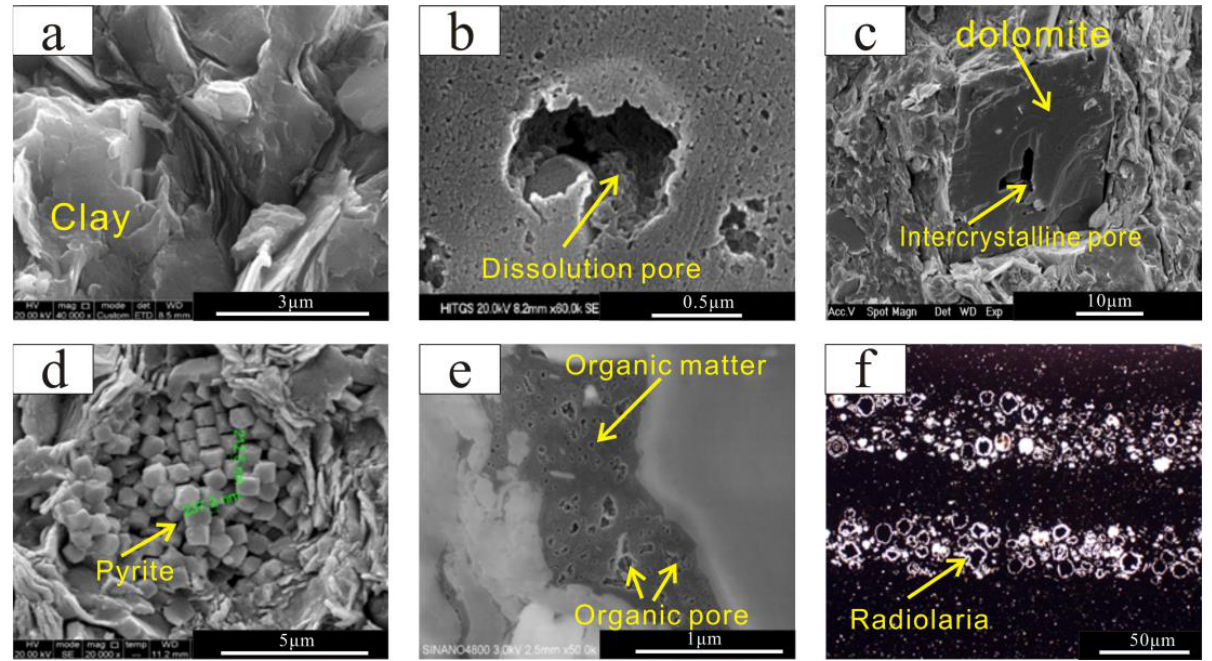
Figure 5. Typical observations of multiple types of pores in shale samples. ( a ). Intermineral pores of flaky clay, N3, 2241.34 m; ( b ). Dissolved pores in mineral particles, 2245.31 m, N4; ( c ). Intracrystalline dissolved pores in carbonate rocks, N3, 2370.77 m; ( d ). Intercrystalline pore of pyrite, N3, 2352.60 m; ( e ). Organic micropores, N3, 2370.77m; ( f ). Radiolarian coelom, N2, 2243.83m.